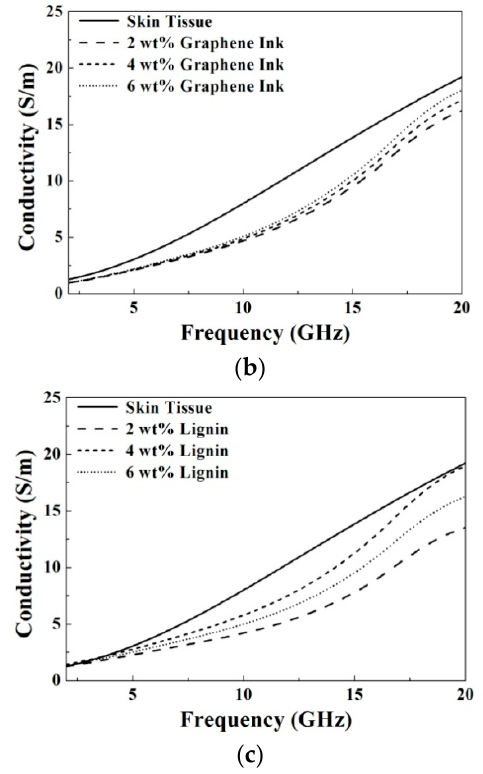
Figure 11. Comparison of conductivities between the skin tissue and the prepared samples with different doping concentrations of ( a ) carbon nanotube; ( b ) graphene ink and ( c ) lignin.